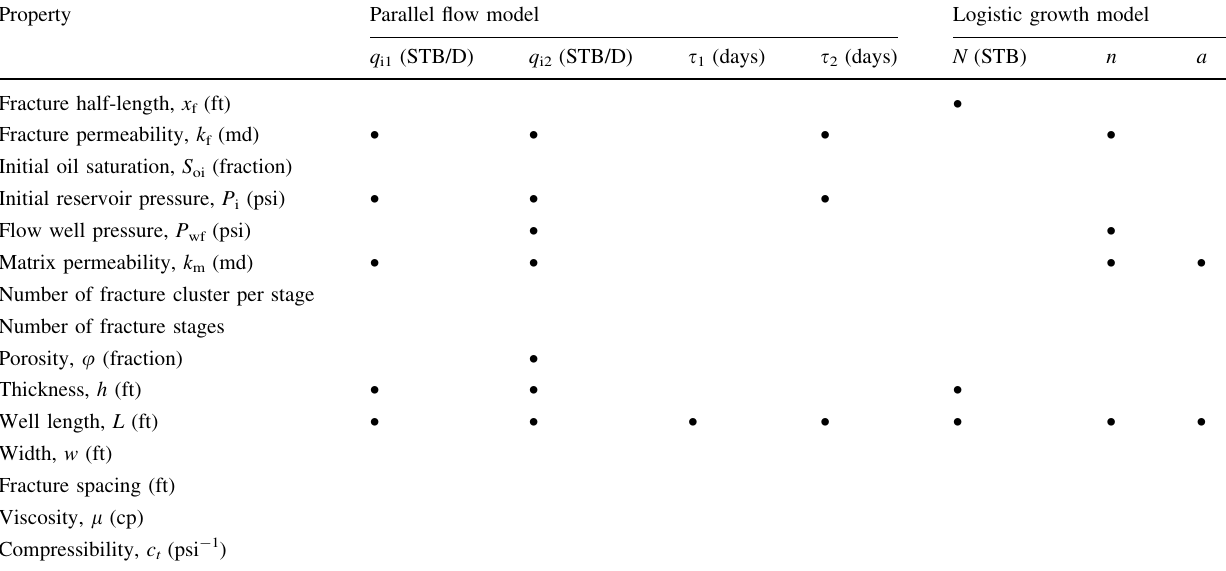
Table 8 Summary of reservoir and well properties that have the strongest effect on the model parameters